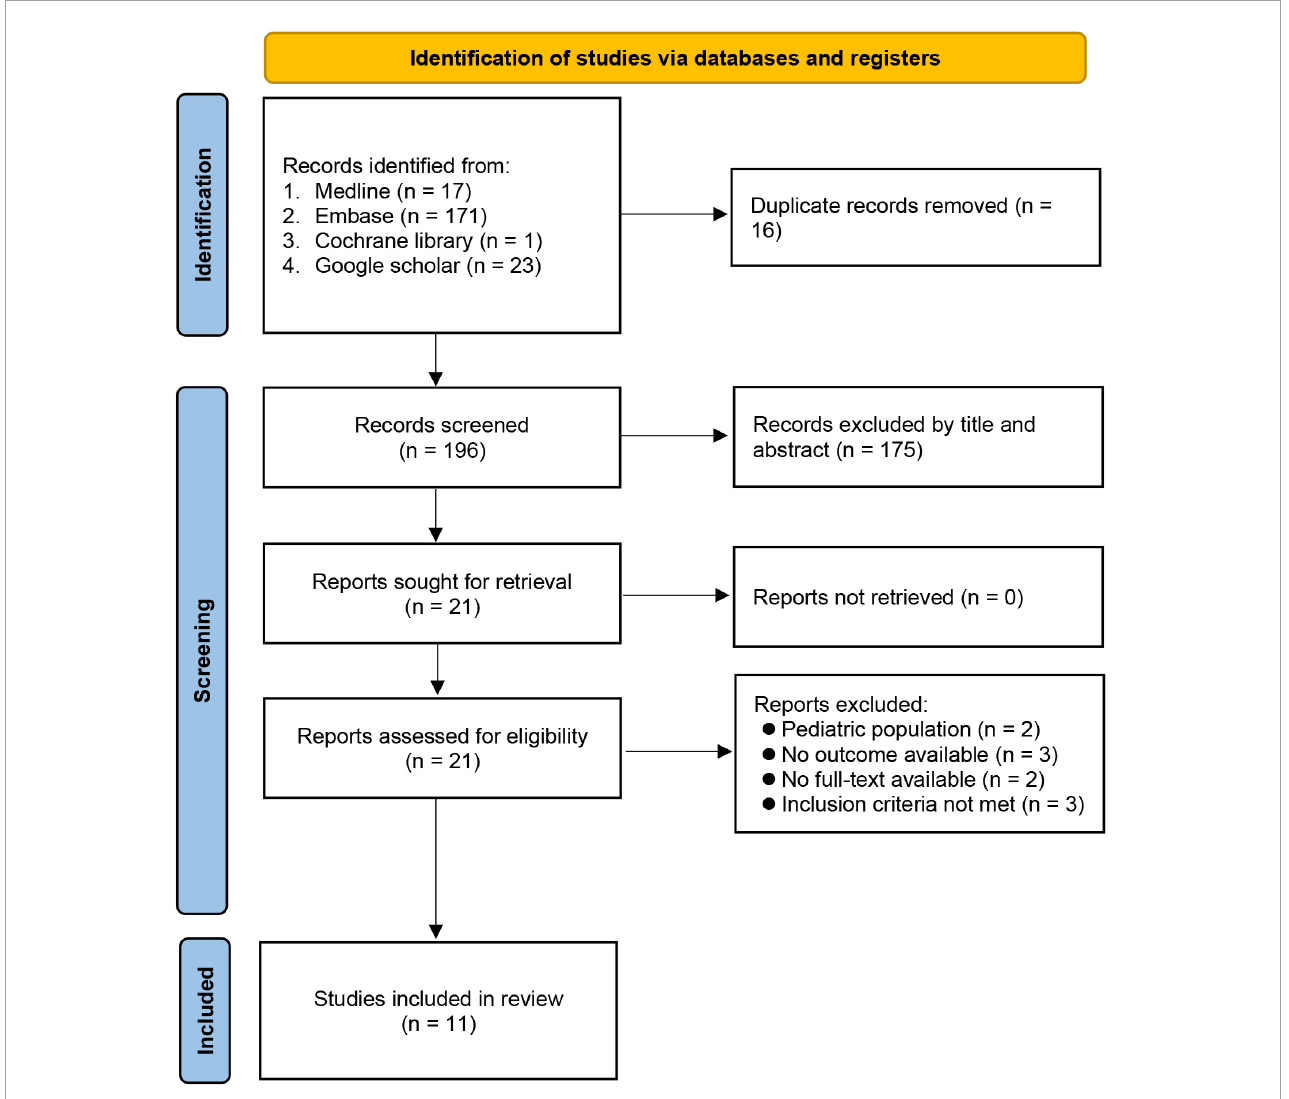
FIGURE1 PRISMA flow diagram of study selection for the current